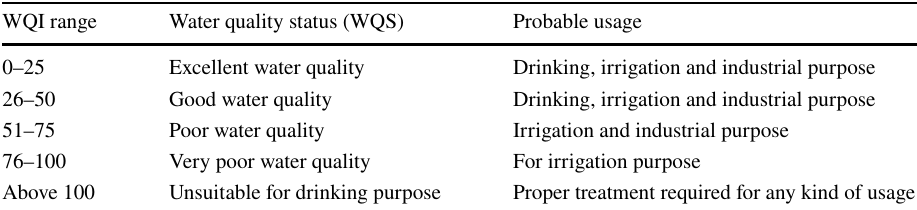
Table 3 Seasonal mean value, range and statistical variation of water quality parameters of Doyang River